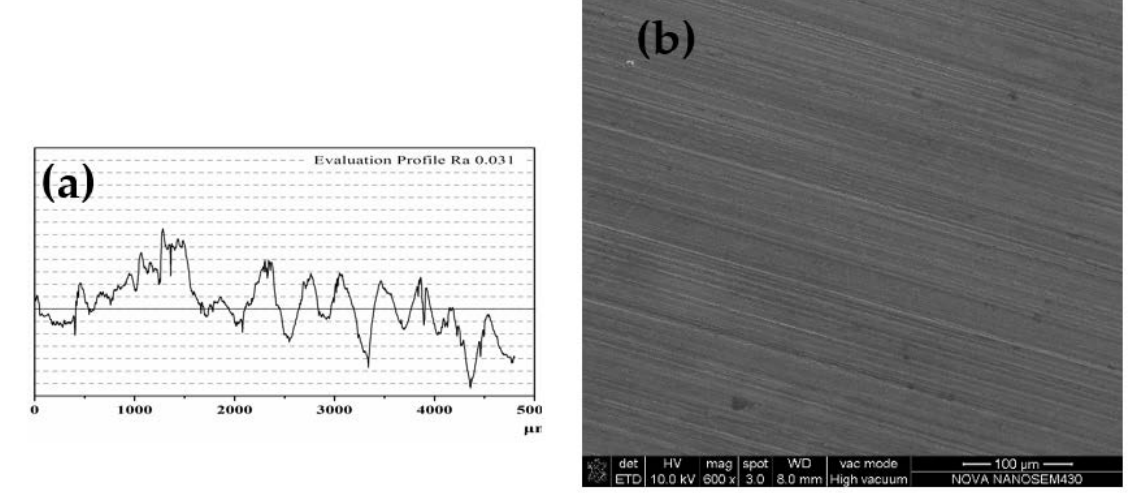
Figure 2. ( a ) Surface roughness and ( b ) morphology.